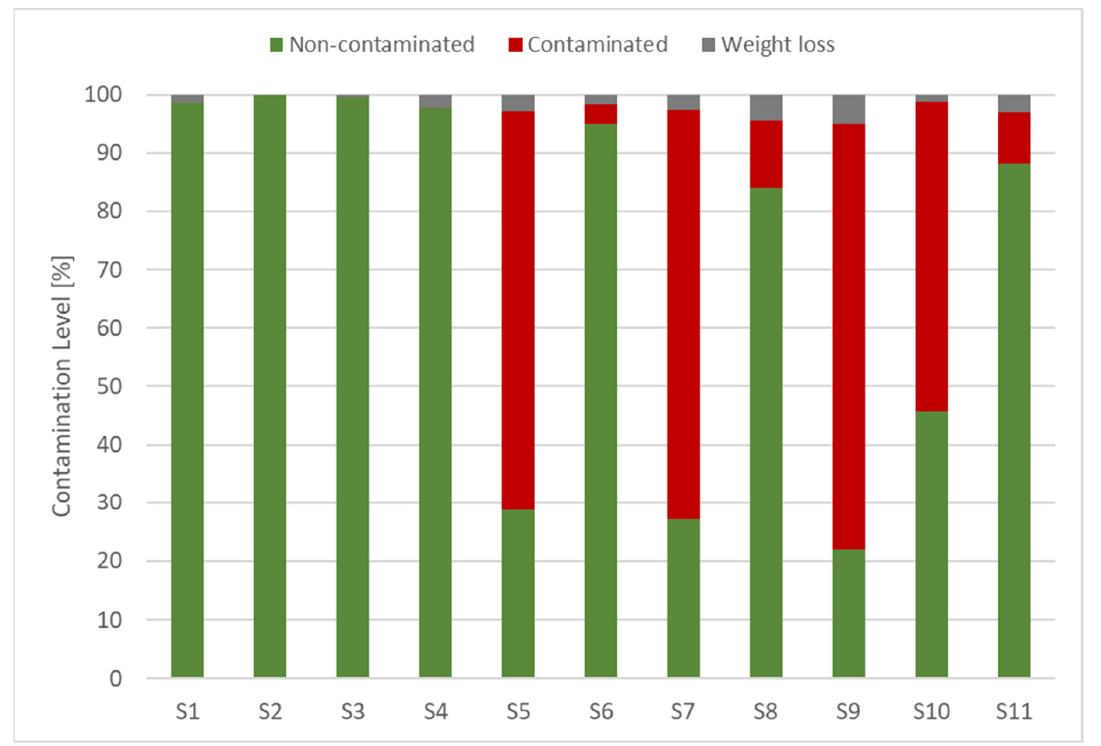
Figure A5. Contamination level of metallic residues by ICP-OES analyses (assuming a provisional limit value of 0.5 wt% for the metallic residues).